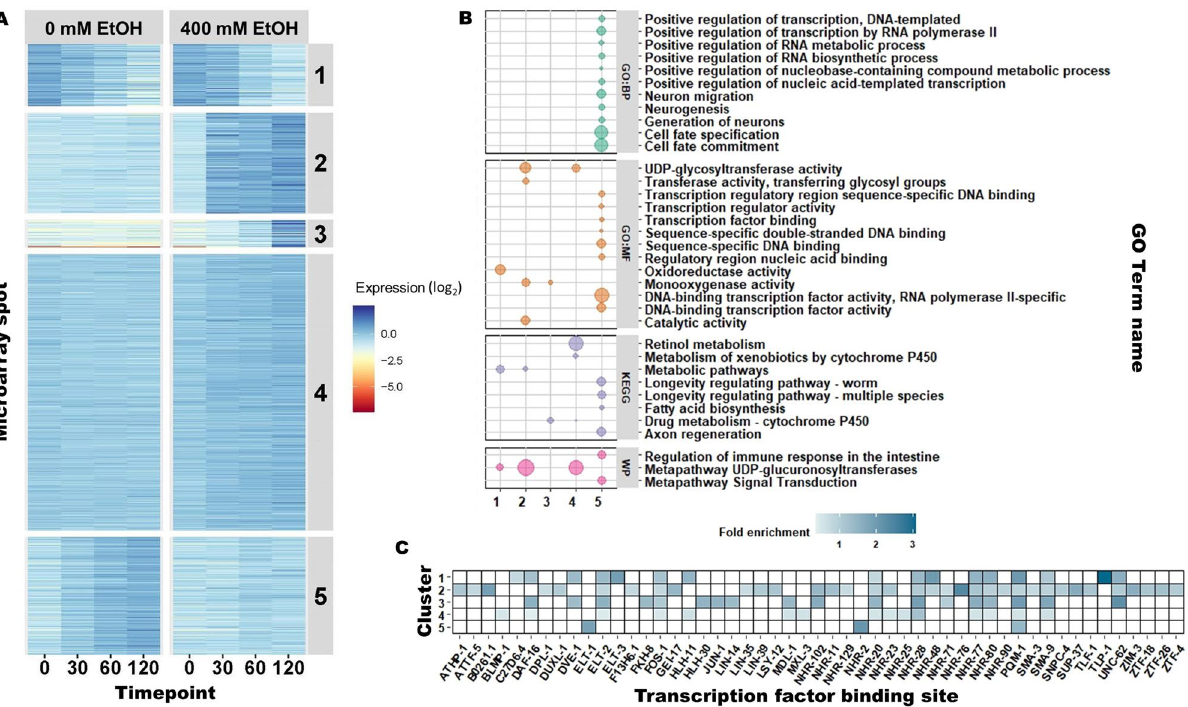
Figure 4. k-means clustering of differentially expressed genes. ( A ) differentially expressed genes clustered per expression pattern. Timepoints tested are on the x-axis and on the y-axis are the 959 microarray spots that represent differentially expressed genes (− log 10 (p) > 3.7). The differentially expressed genes were clustered in five groups by k-means clustering: (1) down-regulated over time, (2) early and strong up-regulation upon ethanol exposure, (3) late up-regulation upon ethanol exposure, (4) early and weak up-regulation upon ethanol exposure, and (5) unchanged in ethanol exposed animals, while increasing expression over time in the ethanol untreated animals (this can be interpreted as relatively down-regulated over time upon ethanol exposure). The colors represent the averaged expression over the four replicates per time and treatment combination (as log 2 ratio with the mean). ( B ) Enrichment analysis of the subsequent k-clusters based on various annotations, including: GO-terms and KEGG pathways 88 . ( C ) Enrichment of transcription factor binding sites (TFBS) per K-means cluster. Fold enrichment is shown when the enrichment for the TFBS was significant (FDR < 0.05). The figure was created using R (version 3.5.3 × 64; https:// cran.r- proje ct. org/) and the ggplot2 package (version 3.3.3; https:// ggplo t2. tidyv erse.